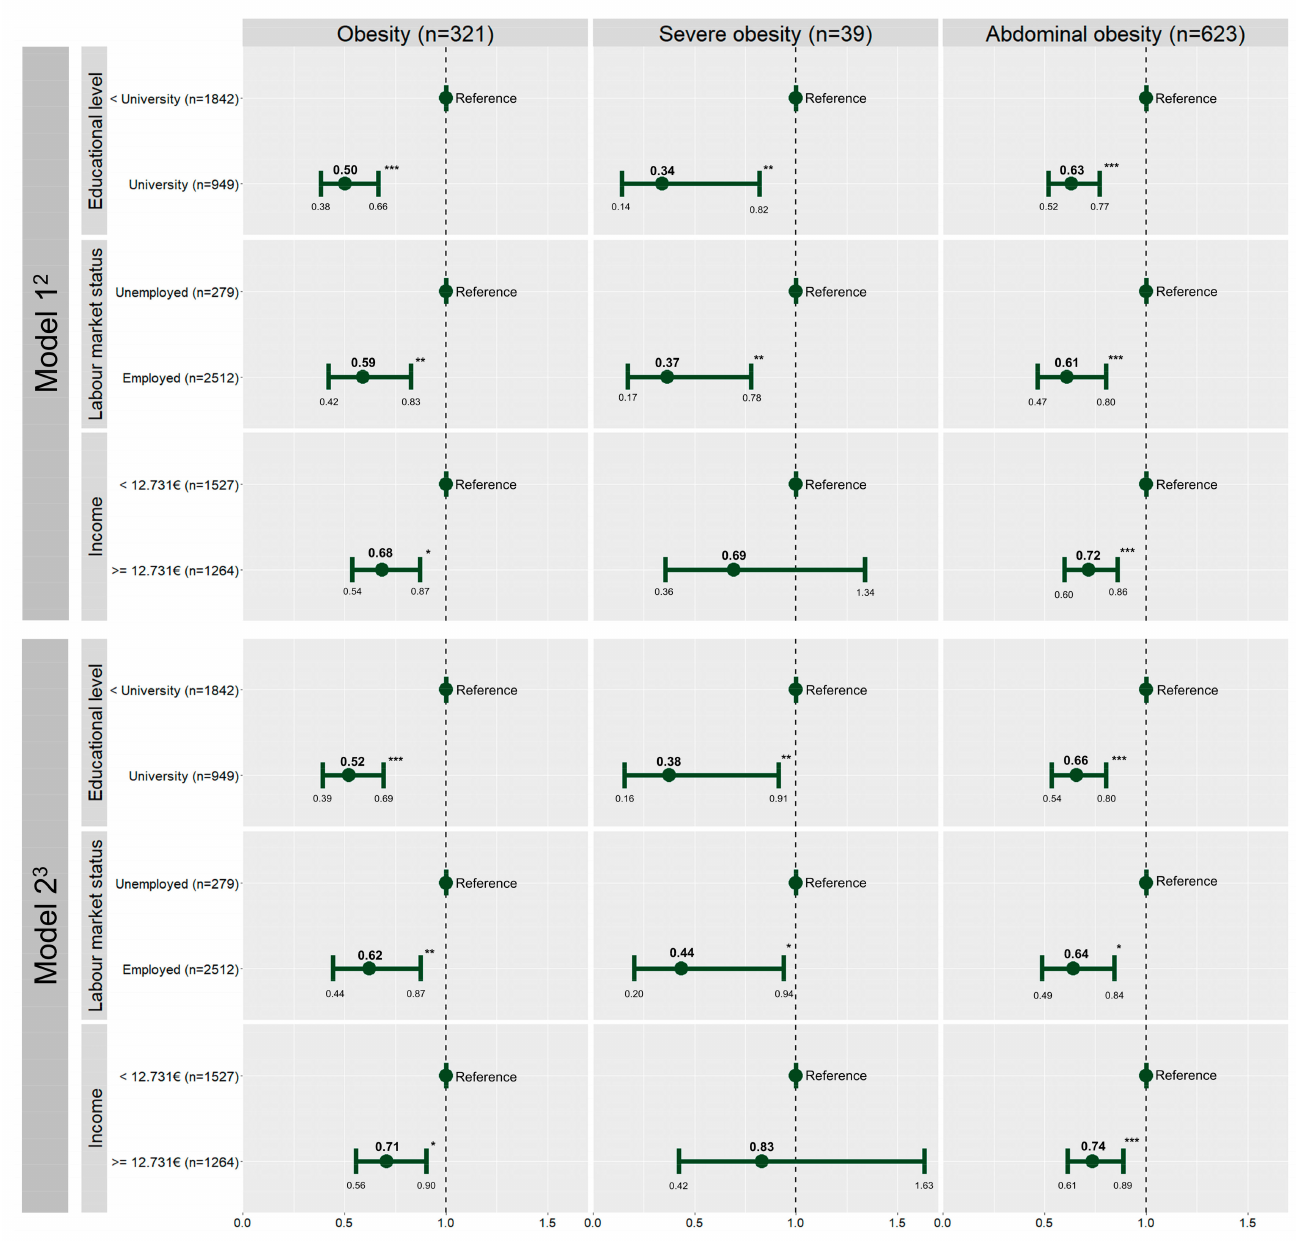
Figure 1. Association between socioeconomic status and general, severe, and abdominal obesity ( n = 2791)—PASOS study. Spain, 2019–2020. 1 1 Performed by logistic regression analysis. 2 Model 1: Adjusted for gender and age. 3 Model 2: Adjusted for gender, age, adherence to the Mediterranean diet, minutes of MVPA, and school. * p < 0.05; ** p < 0.01; *** p <